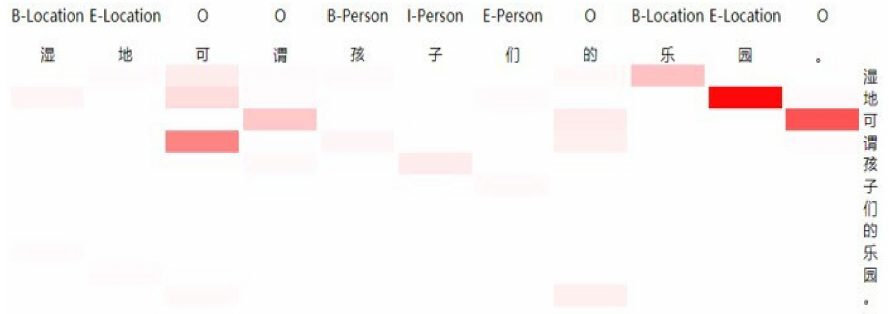
Figure 7. Instance of self-attention visualization 2.